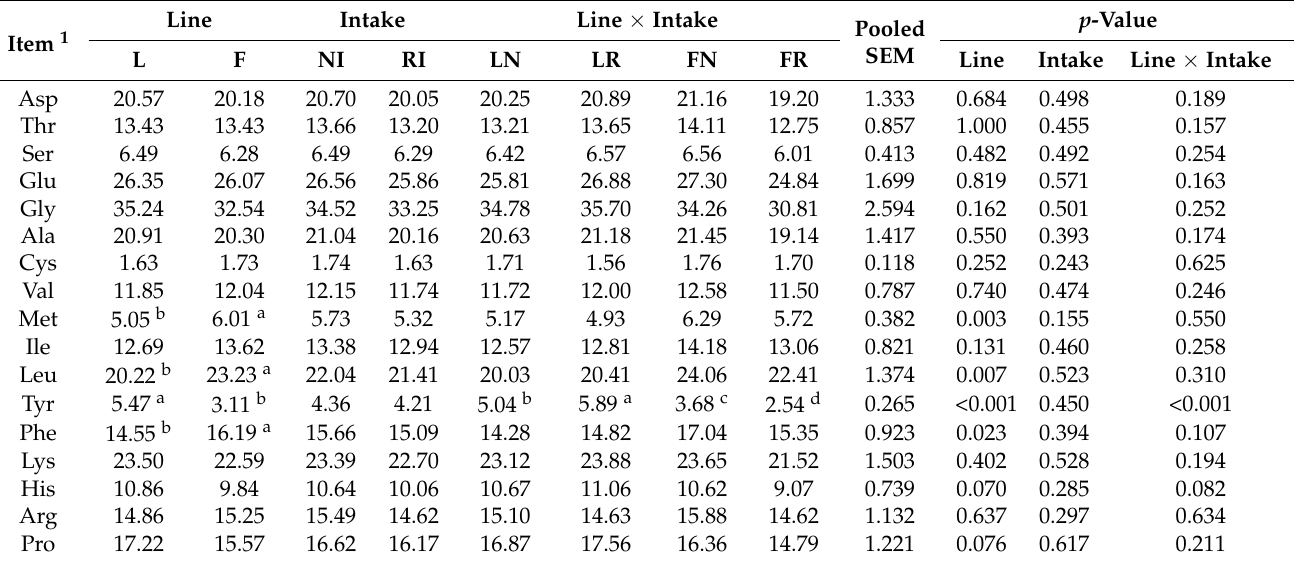
Table 6. Effect of feed intake on amino acids contents of 56-day-old offspring breast muscle meat in broiler hens during the laying period (n =